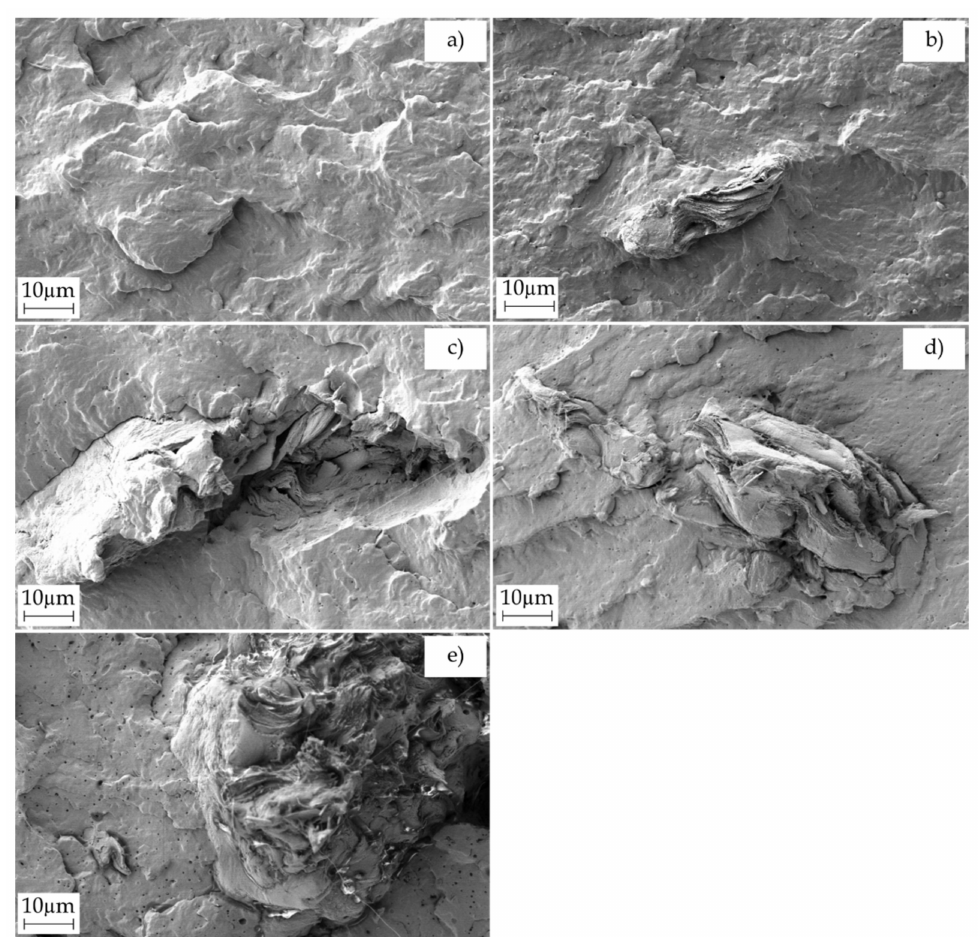
Figure 3. Field emission scanning electron microscopy (FESEM) images of the fracture surfaces of the injection-molded pieces of poly(butylene succinate) (PBS)/pistachio shell flour (PSF) compatibilized with poly(butylene succinate) grafted with maleic anhydride (PBS- g -MAH): ( a ) PBS, ( b ) PBS-5PSF, ( c ) PBS-10PSF, ( d ) PBS-20PSF, and ( e ) PBS-30PSF. Images were taken at 1000 × with scale markers of 10 µ